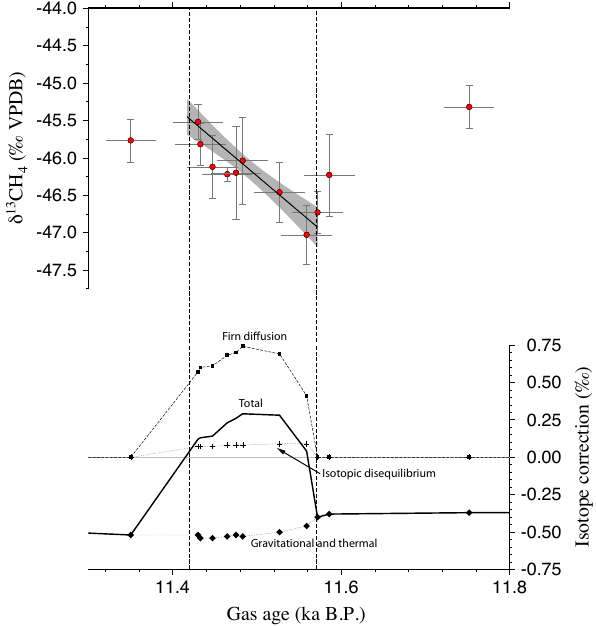
Fig. 6. The gravitational, thermal, diffusion, and isotopic equilib- rium isotope corrections for the P˚akitsoq δ 13 CH 4 record. The upper panel is the P˚akitsoq δ 13 CH 4 record from this study – the Schaefer et al. (2006) values were treated identically but are not plotted here for clarity. The linear regression model (as in Fig. 2) using P˚akitsoq data points from the combined dataset (this study and Schaefer et al., 2006) is shown. The bottom panel shows the isotope corrections as applied to each data